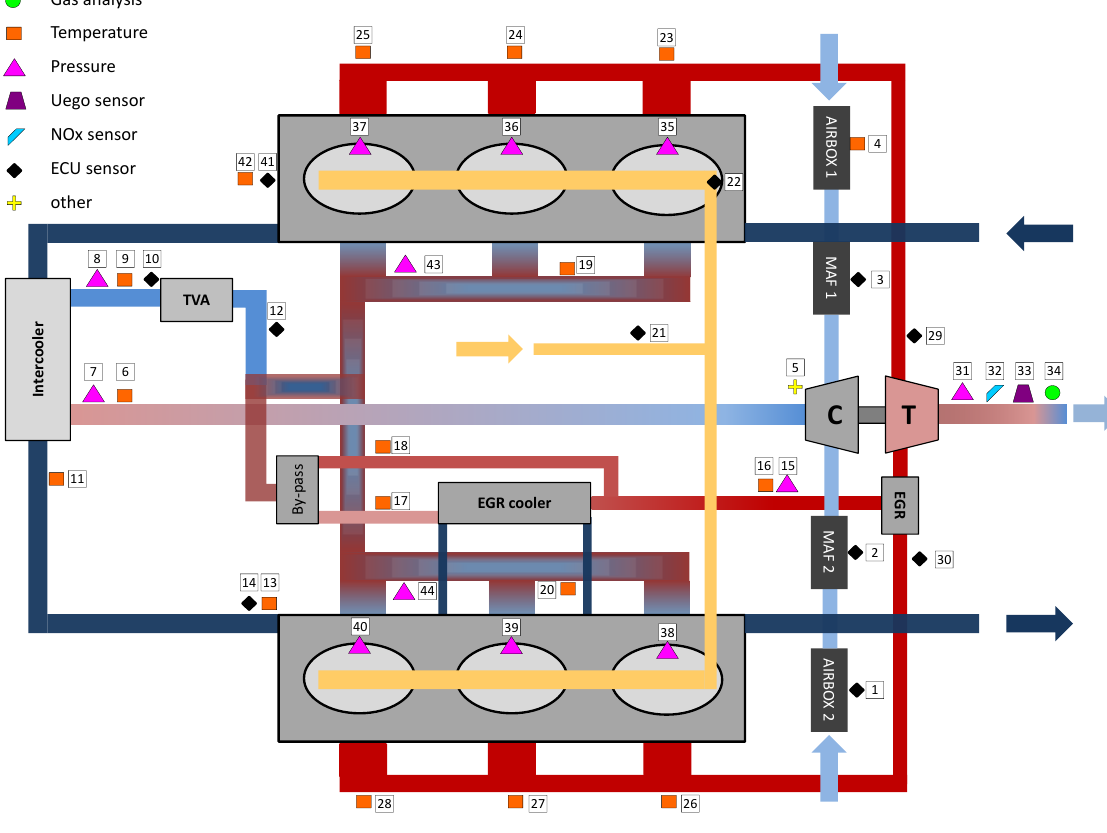
Figure 6. Layout of the diesel engine used in this work, showing the various types of sensors installed. ECU: electronic control